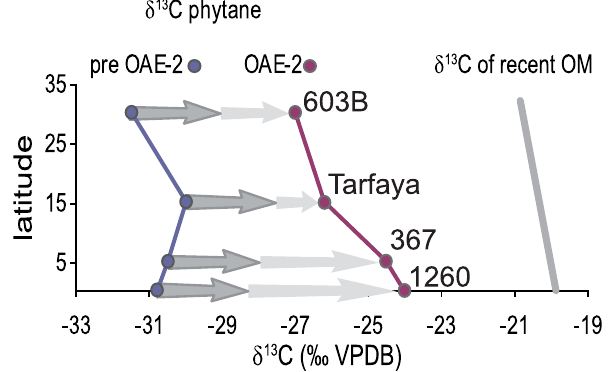
Fig. 4. Latitudinal gradient in δ 13 C phytane prior to OAE-2 and dur- ing OAE-2 (Site 1260, this study; Site 367, Kuypers et al., 2002b; Tarfaya, Tsikos et al., 2004; Site 603B, Sinninghe Damst´e et al., 2008) compared to the gradient observed in the δ 13 C of recent OM (from Rau et al., 1982). The dark grey arrows indicate the size of the δ 13 C phytane excursion that has been interpreted as the result of enhanced global OM burial, the light grey arrow represents the amount of the excursion that is due to local variations.